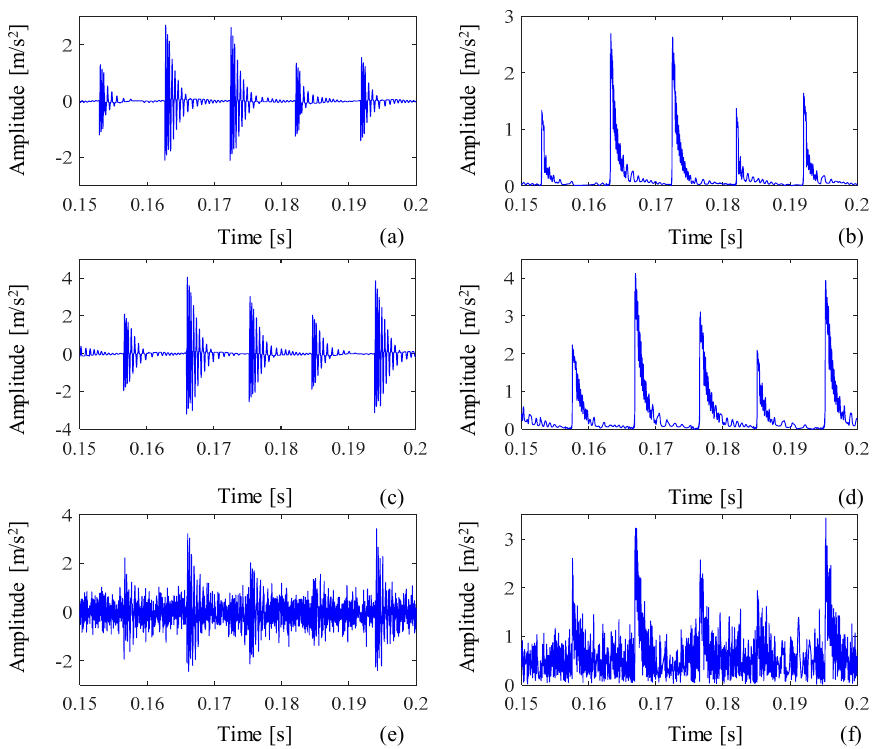
Figure 7. The generated data with the outer race fault: ( a , c , e ) the original data at different speeds, different pre-loads, and with noise; ( b , d , f ) are the envelop data at different speeds, different pre-loads, and with noise.